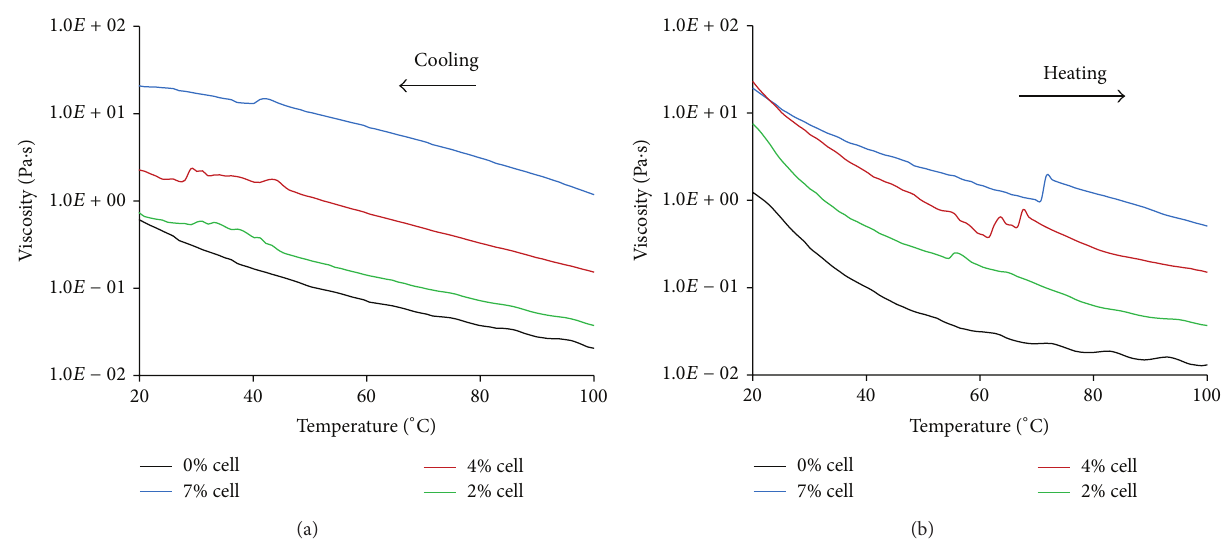
Figure 2: Viscosity profiles for cellulose in AMIMCl solution on cooling (a) and heating (b). Pure AMIMCl (black), 2% cellulose (green), 4% cellulose (red), and 7% cellulose (blue) solutions.